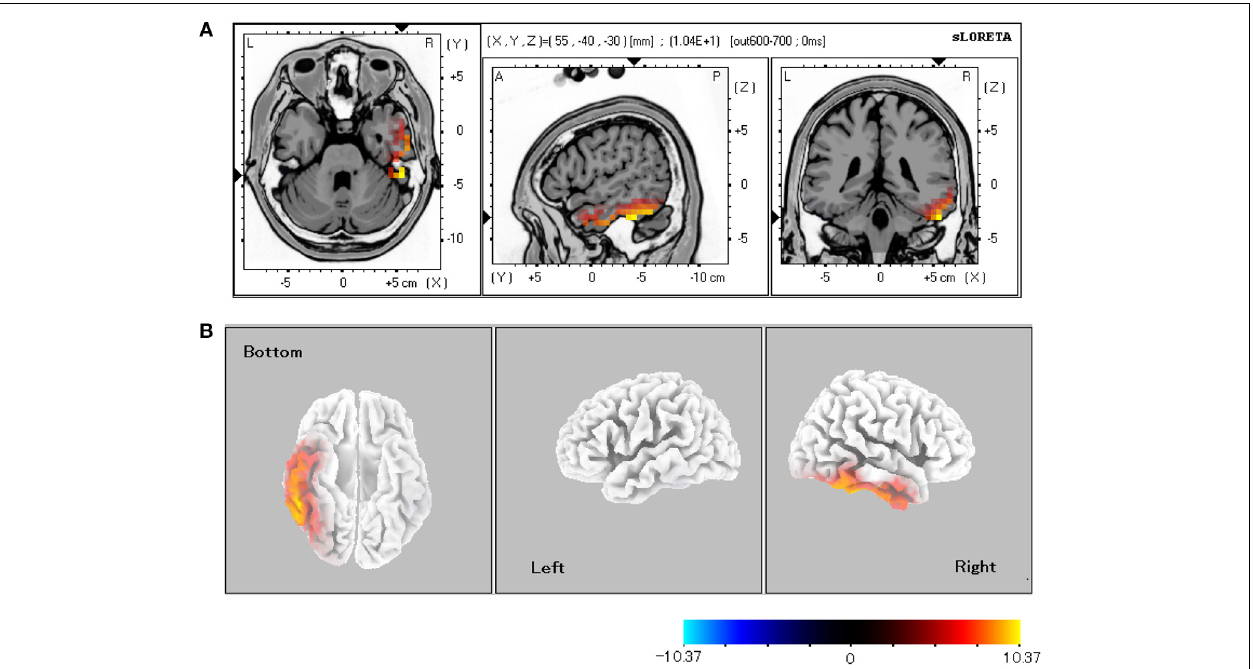
The statistically significant regions acquired from all the subjects were displayed on a standard brain template in (A) . The source estimation indicates the significant roles ( p < 0 . 05 for all the subjects) of the right lateral fusiform gyrus.